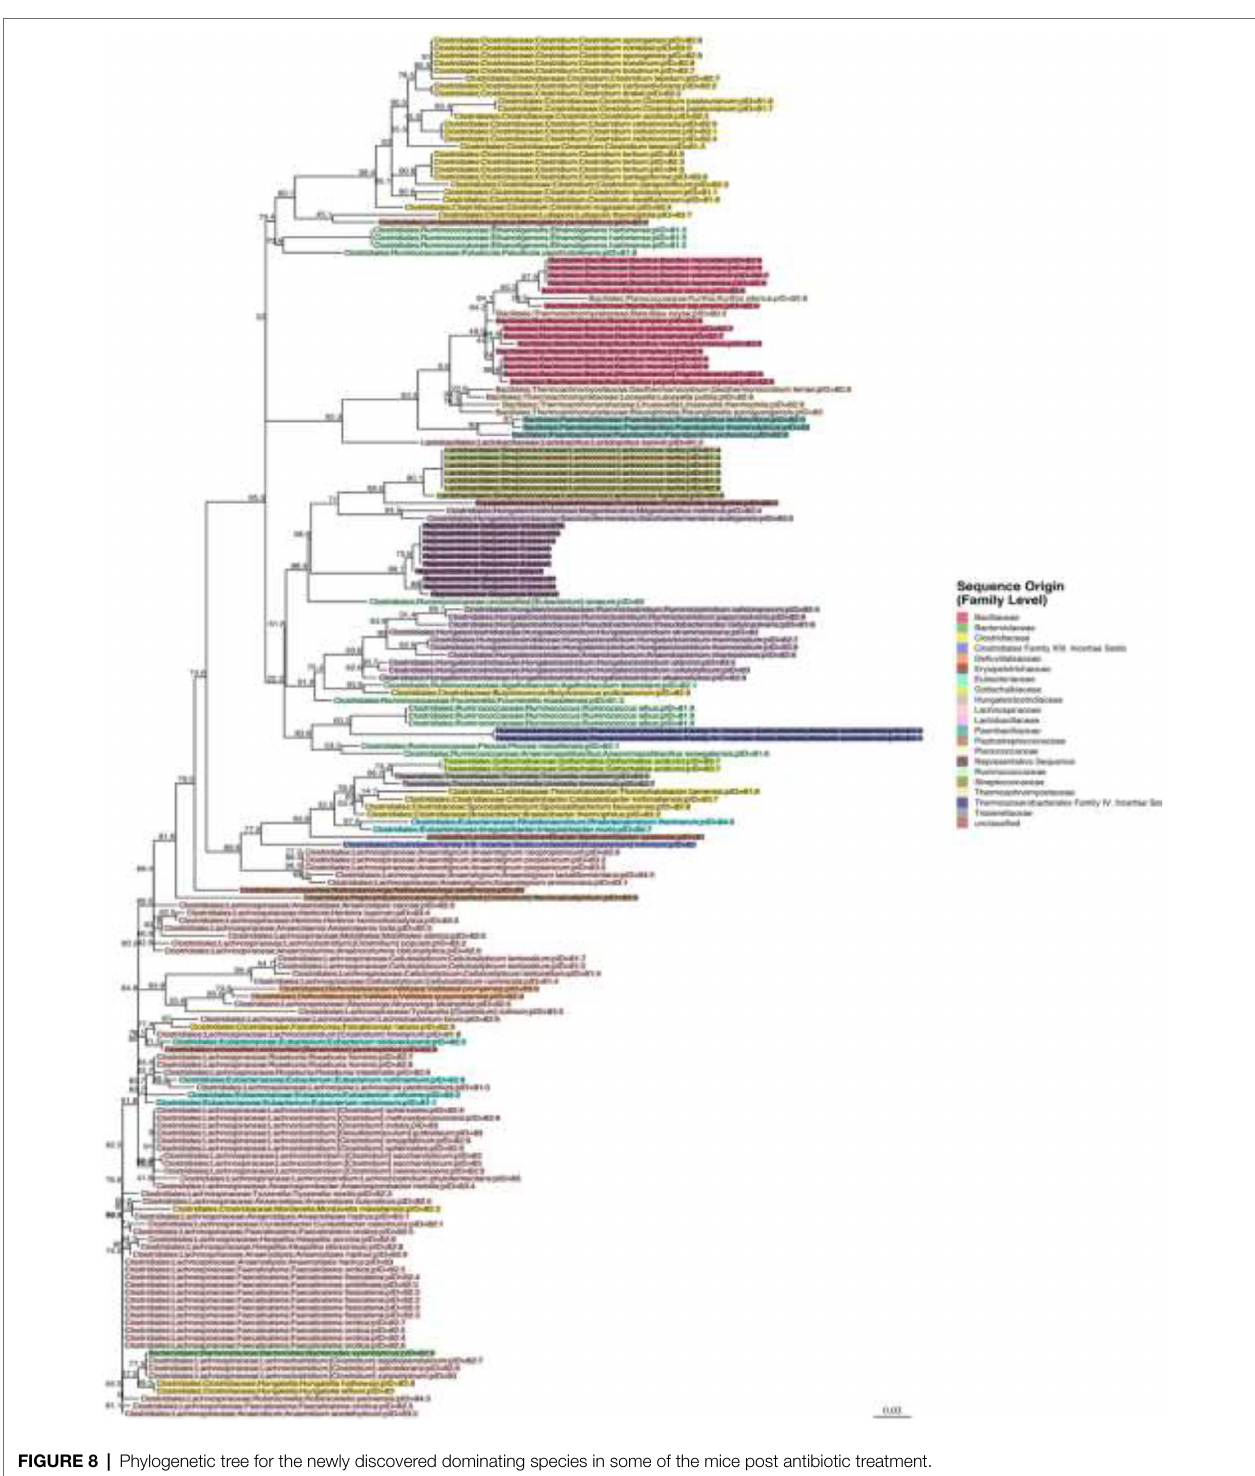
FIGURE 8 | Phylogenetic tree for the newly discovered dominating species in some of the mice post antibiotic